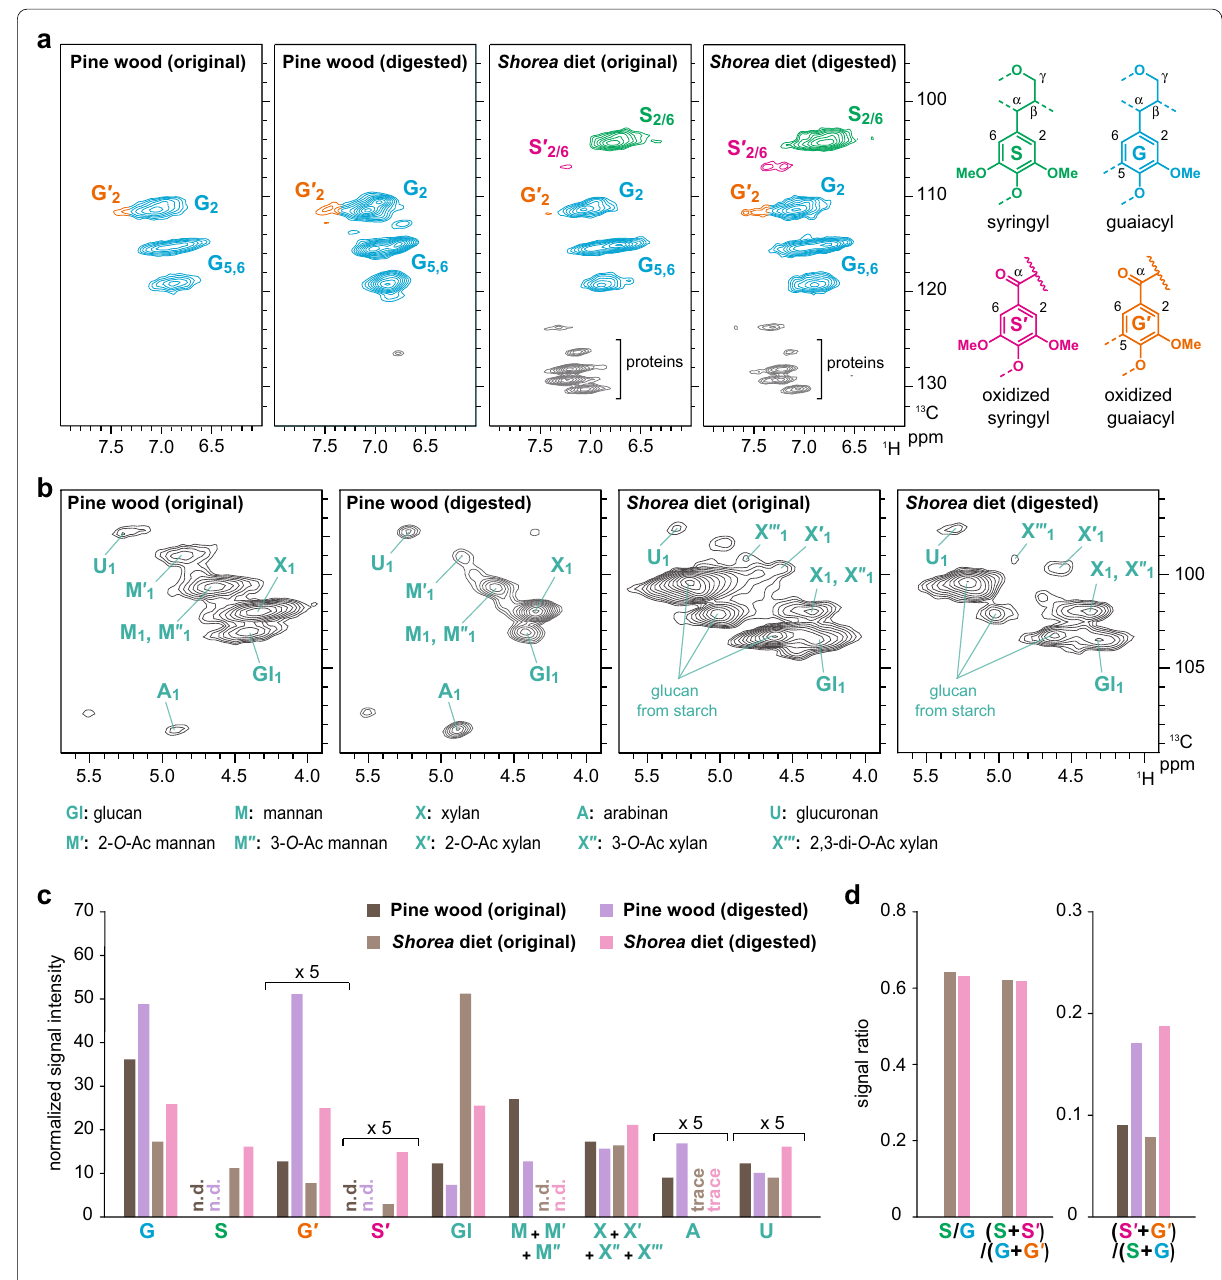
Fig. 3 Lignin aromatic units and polysaccharides in original and digested diet samples of N. hirtum. Aromatic ( a ) and polysaccharide anomeric ( b ) sub-regions 2D HSQC NMR spectra of pine wood and Shorea artificial diet lignocellulose samples before (“original”) and after (“digested”) digestion by N. hirtum larvae. Figures show normalized signal intensity values of major lignin aromatic and polysaccharide anomeric signals expressed as percentages of the sum of the listed signals (see Materials and methods) ( c ) and ratios of non-oxidized and oxidized syringyl (½ S 2/6 and ½ S ʹ 2/6 ) and guaiacyl ( G 2 and G ʹ 2 ) lignin aromatic signals ( d ). Data labeled 5 indicate that the reported values are multiplied by 5 for visualization purposes. × Peak assignments are listed in Table